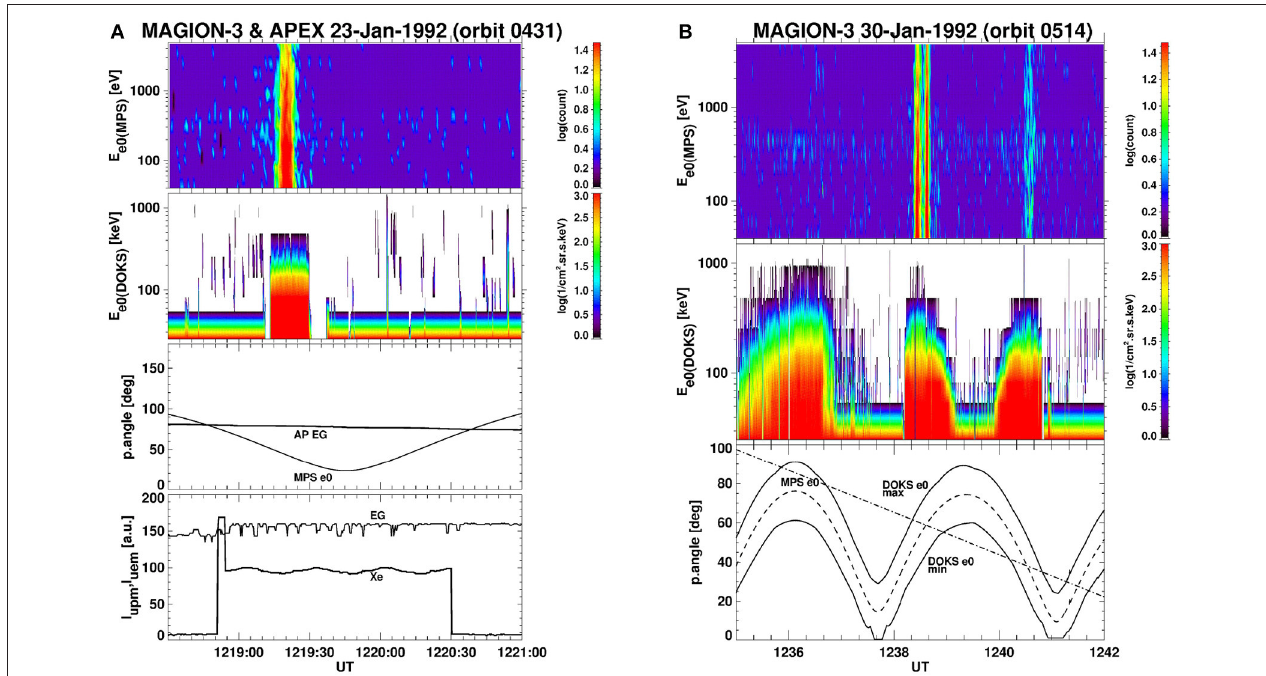
FIGURE 11 | Examples of single and multiple electron bursts registered onboard MAGION–3. (A) From top to bottom: MPS e0 channel dynamic spectrogram (to 5 keV , parallel to the satellite axis); DOK–S e0 channel spectrogram up to 1 MeV ; IK–25 UEM electron beam pitch angle (AP EG) and the pitch angle of MPS e0 electrons; monitors of the IK–25 UEM and UPM injectors. (B) From top to bottom: MPS e0 and DOK–S e0 channel spectrograms; pitch angle of electrons registered by MPS e0 (dashed line), the range of pitch angles covered by the DOK–S e0 channel (two thin min/max lines), and the approximate change of the electron burst pitch angle with time (dash-dotted line). (Originally published in Prech et al., 2002, distributed under the Creative Commons Attribution 3.0